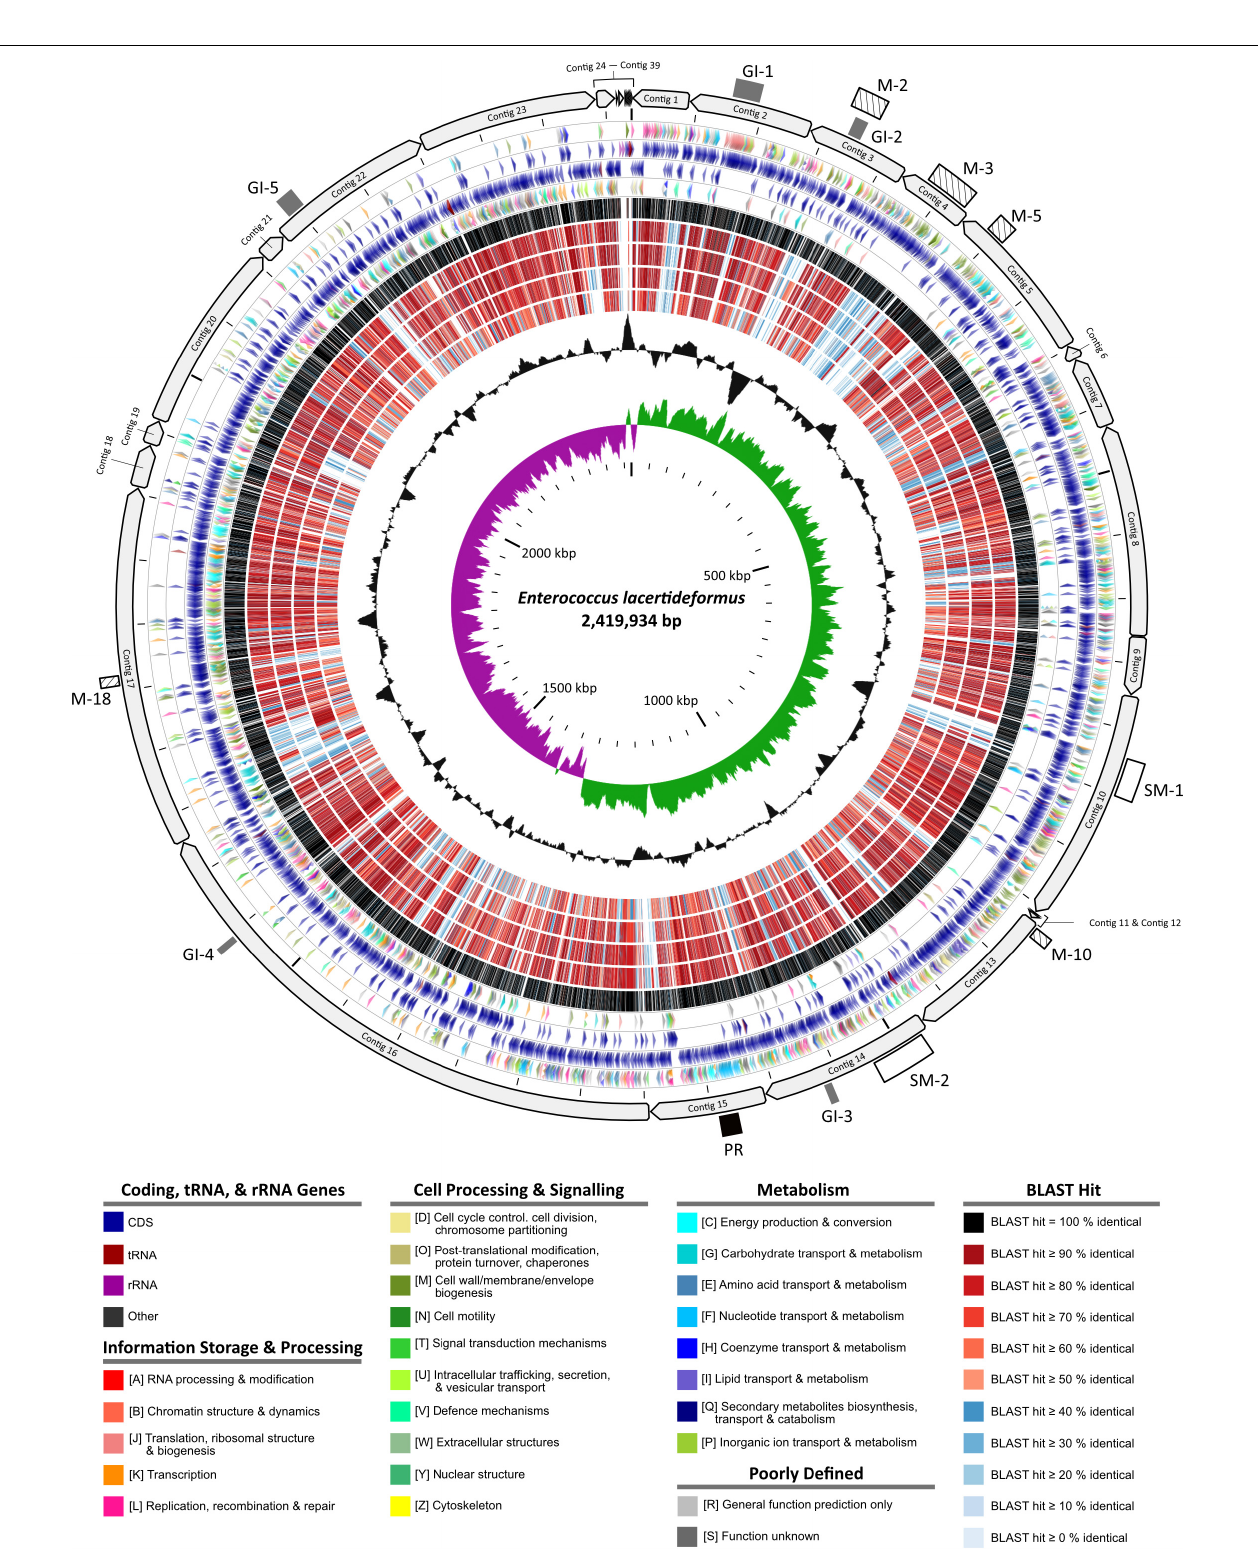
FIGURE 1 | Circular map of the Enterococcus lacertideformus genome. A graphical circular map of the incomplete E. lacertideformus genome performed with the CGview comparison tool (Stothard et al., 2019). Contigs were ordered against the E. hirae R17 genome using Mauve Contig Mover. Concentric rings from outside